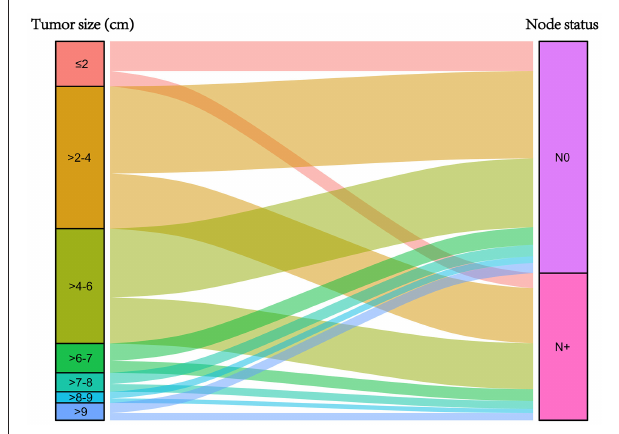
FIGURE 1 | Graphical summary of tumor size and lymph node status, and their subgroup distribution.